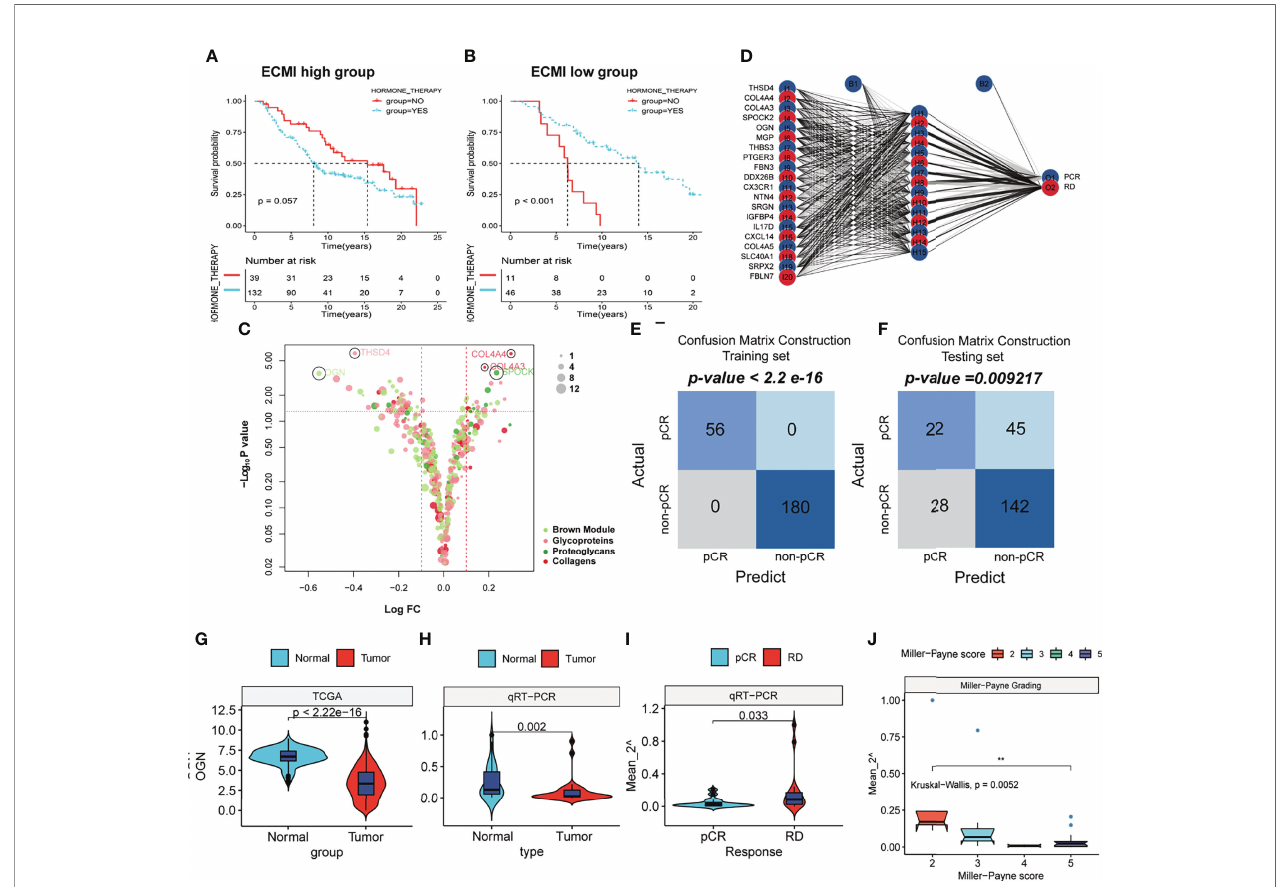
FIGURE 7 | The prediction of hormone and neoadjuvant chemotherapeutic ef fi cacy based on the ECM signature. (A, B) Kaplan – Meier survival analysis of the patients with or without hormone therapy in ECMI high and low groups. (C) Volcano plot showing the differentially expressed genes (DEGs) between patients with pCR and non-pCR. (D) Schematic diagram of the neural network established by the 20 DEGs. (E, F) Contingency tables show the consistency between the predicted clusters and the actual clusters. (G, H) Violin plots showing the different levels of OGN between Normal and Tumor tissues in TCGA cohort and Harbin Medical University cohort. (I) Violin plots exhibiting the different levels of OGN between pCR and RD tissues. (J) Violin plots exhibiting the different levels of OGN among different MP